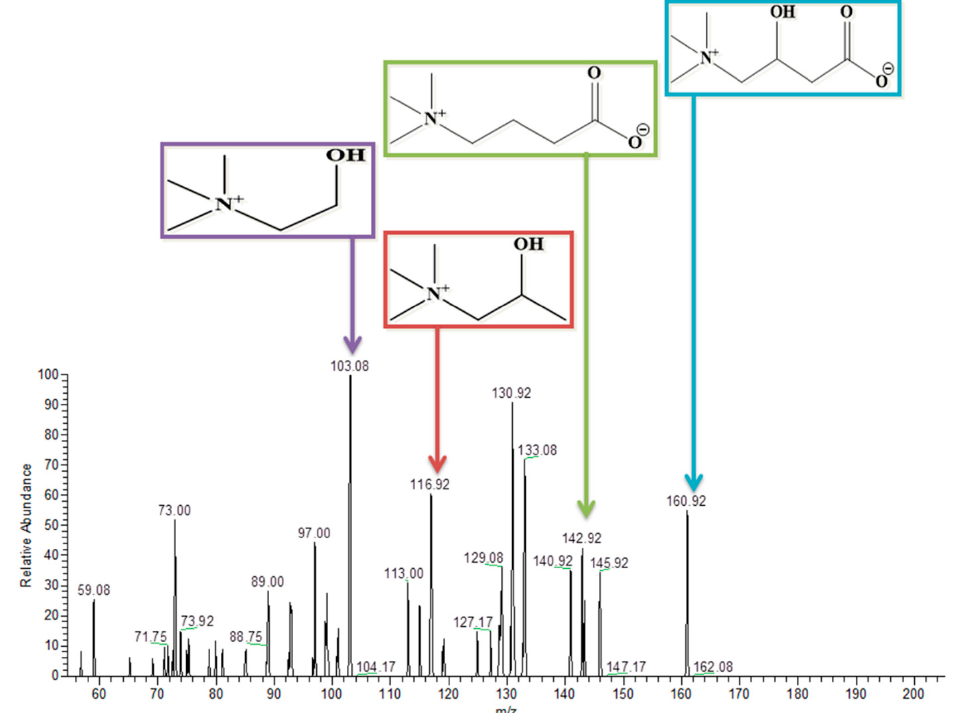
Figure 8. MS/MS spectrum of Lysophosphatidylcholine in positive ion mode.